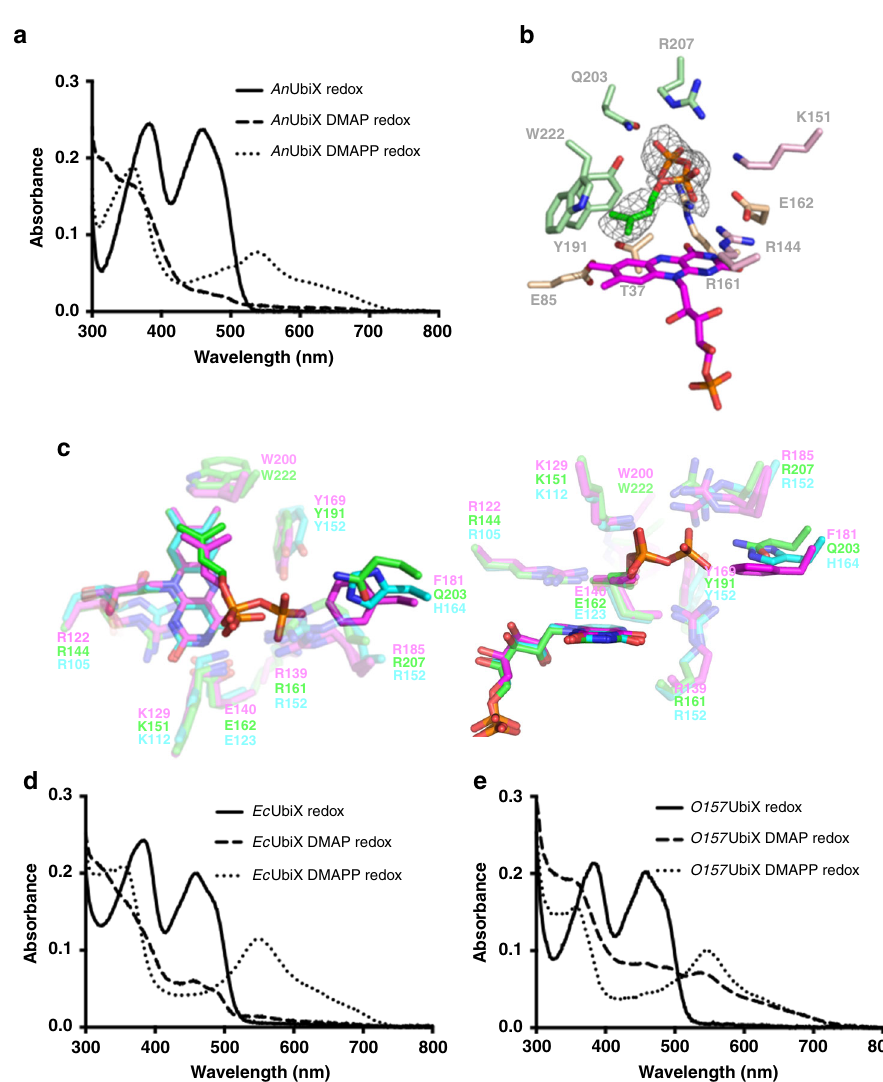
Fig. 2 Structure and properties of DMAPP-speci fi c UbiX enzymes. a UV – Vis spectra of FMNH 2 : An UbiX incubated with buffer, DMAP or DMAPP, respectively, following oxidation. Only the DMAPP substrate leads to formation of a purple prFMN semiquinone. Crucially, DMAP incubation does affect the resulting FMN spectrum. b The crystal structure of An UbiX in complex with FMN and DMAPP. The An UbiX active site is shown with the omit polder map corresponding to bound DMAPP contoured at 3 sigma. Residues are coloured according to different An UbiX monomers. c A structural overlay of Pa UbiX (magenta), An UbiX (green) and O157 UbiX (cyan) active sites. This reveals a highly conserved network of residues with the exception of divergence at position 181 ( Pa UbiX numbering). Right image is a 90° rotation about the x -axis. d UV – Vis spectra of FMNH 2 : Ec UbiX incubated with buffer, DMAP or DMAPP, respectively, following oxidation. A similar behaviour to An UbiX is observed. e UV – Vis spectra of FMNH 2 : O157 UbiX incubated with buffer,